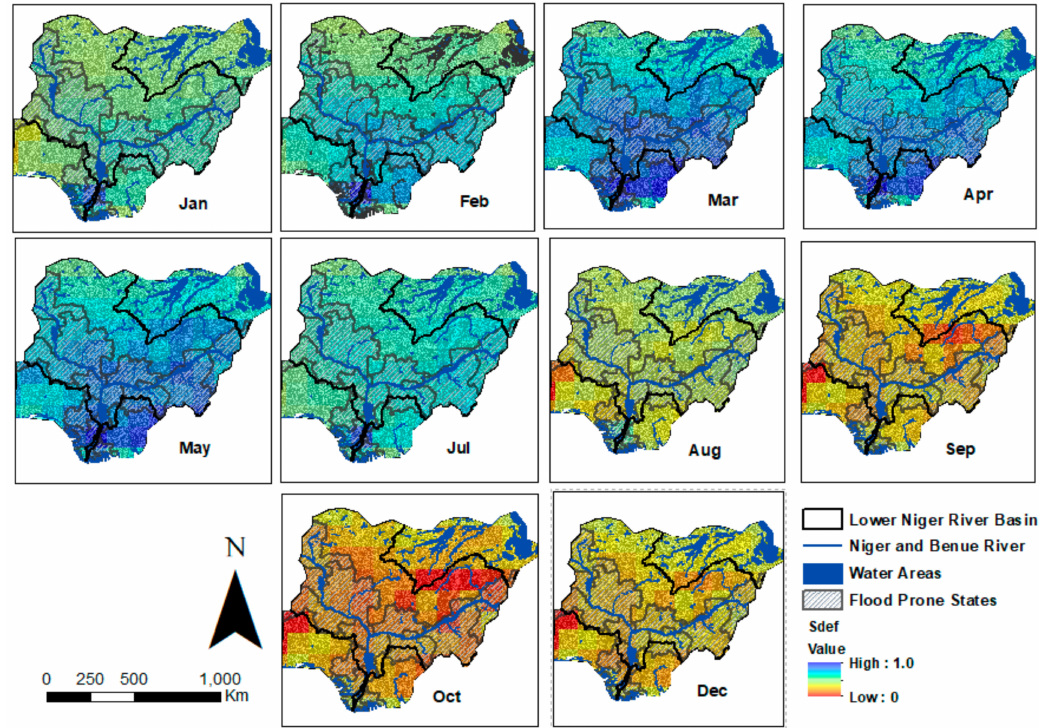
Figure 10. Spatiotemporal display of storage deficit ( Sdef ) (normalized) in the LNRB from January to December 2012. May and October 2012 are missing months in the GRACE TWSA time series due to battery management. Hence, no Sdef and flood potential index ( FPI ) for June and November. The red color shows areas with low Sdef while the blue areas represent areas with high Sdef